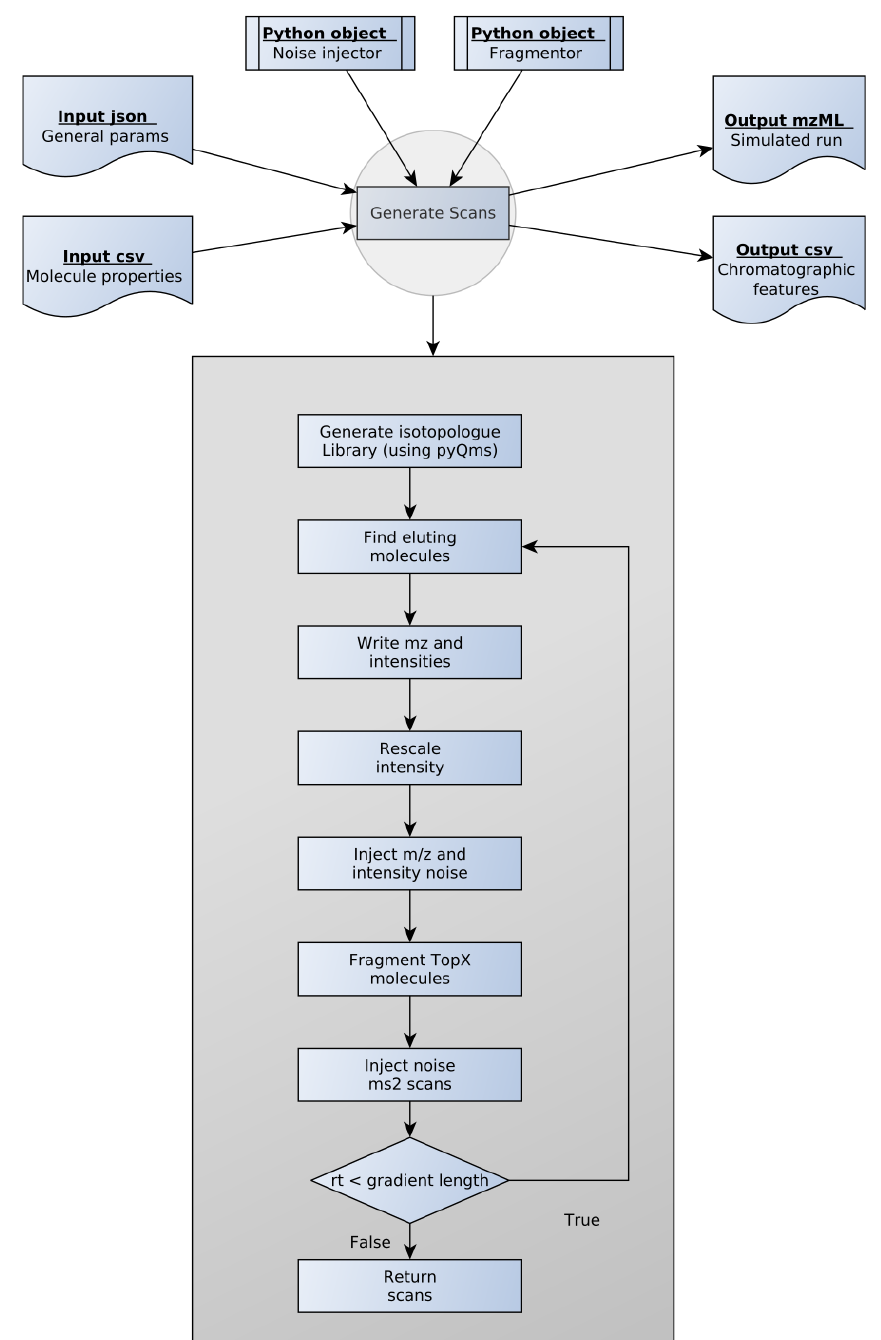
Figure 1. Overview of the SMITER workflow. For each simulation, the user provides two input files containing the general parameters and the properties of the molecules. Two output files are generated. The simulated run is provided in mzML format while the chromatographic features are written in csv format. Each file type is indicated as a blue box. The key steps of scan generation are shown in the grey box.